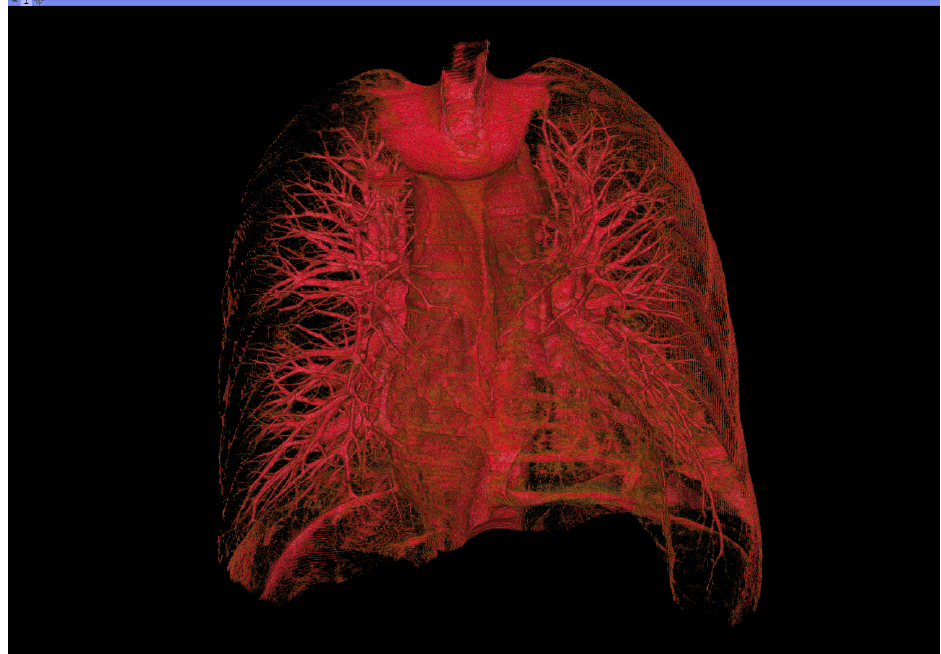
Figure 1. Exemplary 3D rendering of coronavirus disease 19 (COVID-19)-affected lungs. The clinical score S for the depicted patient is equal to 3. In the inferior left lobe, it is possible to see some opacities due to